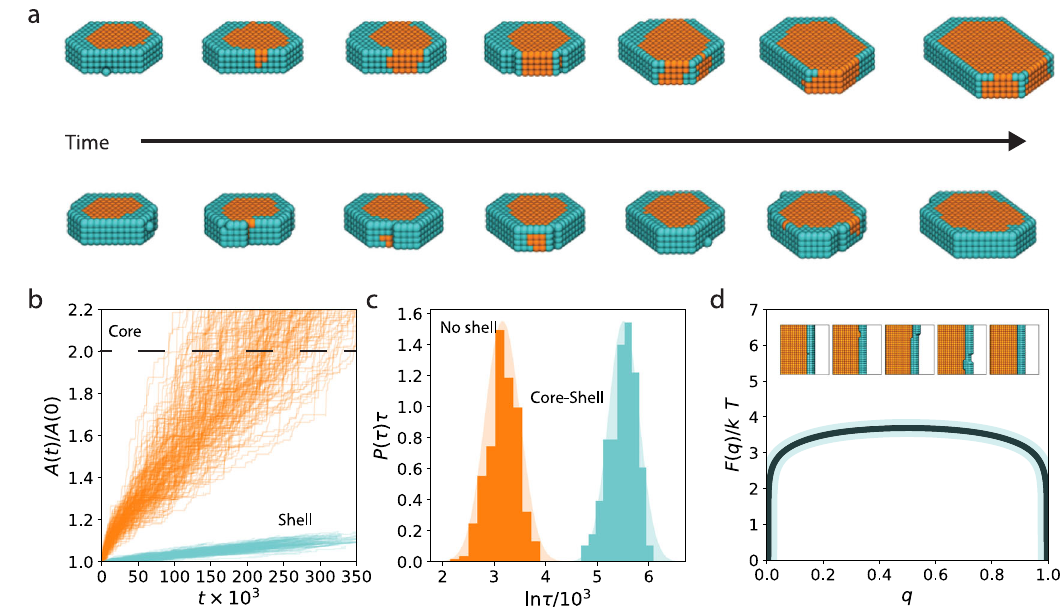
Fig. 5 Lattice model for defect-mediated growth of core-shell nanostructures. a Example time series depicting the growth of an initial defect-free core-shell structure with snapshots taken approximately 10000 MC steps apart. b Example time series of the projected area of the core and shell over the course of coarsening. c Distribution of times for the nanoparticle core to double in size when initialized with and without a shell. d Free energy to grow a new layer of core material, proceeding through the reversible generation of a surface crack. The shadings around the solid lines indicate the standard